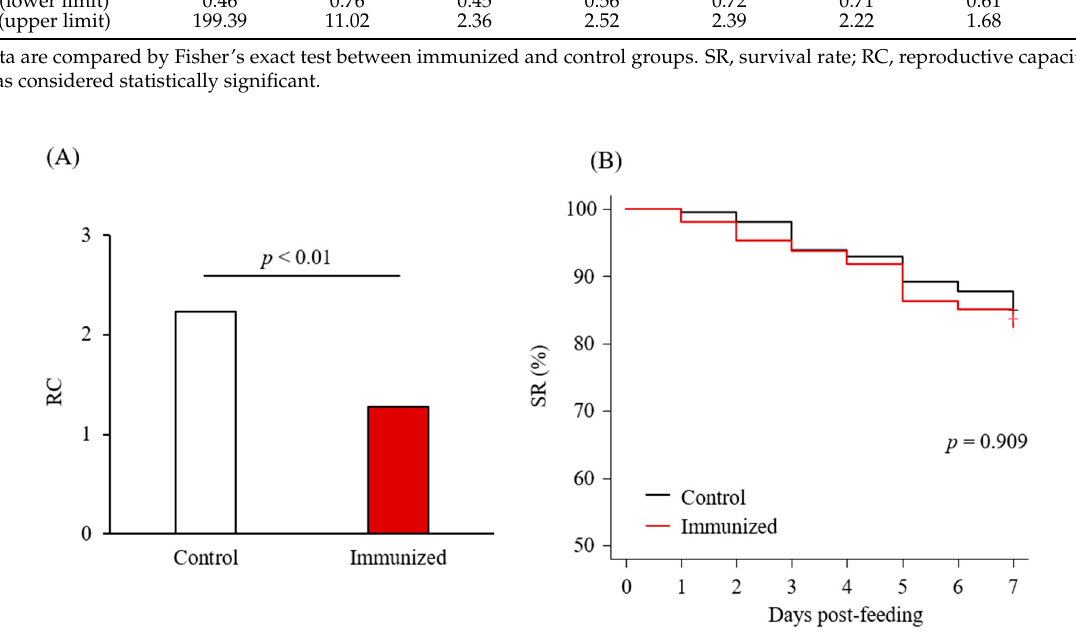
Figure 4. Anti-PRM effects of plasma from chickens immunized with Dg-Cys -his (first experiment). ( A ) The reproductive capacity (RC) at seven days post-feeding was assessed. Statistical analysis was performed using Fisher’s exact test. p < 0.01 was considered statistically significant. ( B ) The survival rate (SR) of PRMs that were fed with the plasma from immunized chickens was assessed every day for a one-week period. Statistical analysis was performed using Log-rank test. Table 2. Summary of the anti-PRM property of Dg-Cys -his immunization (second experiment). Days Post-Feeding MR (%) 1